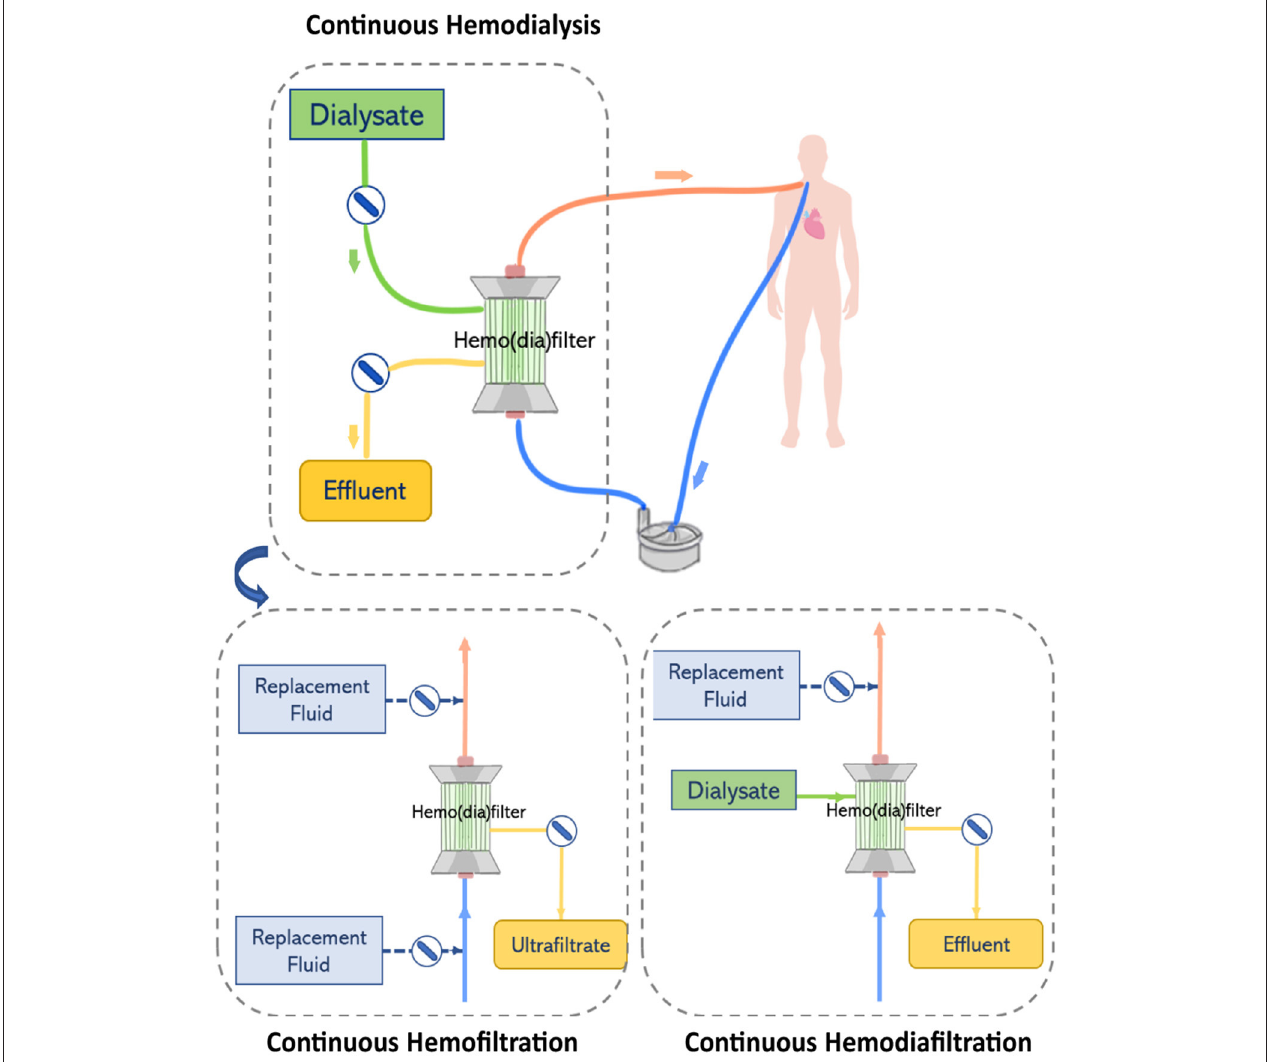
FIGURE 4 | The renal replacement therapy circuit while providing continuous hemodialysis, continuous hemofiltration, and continuous hemodiafiltration. Replacement fluid can be delivered before or after the